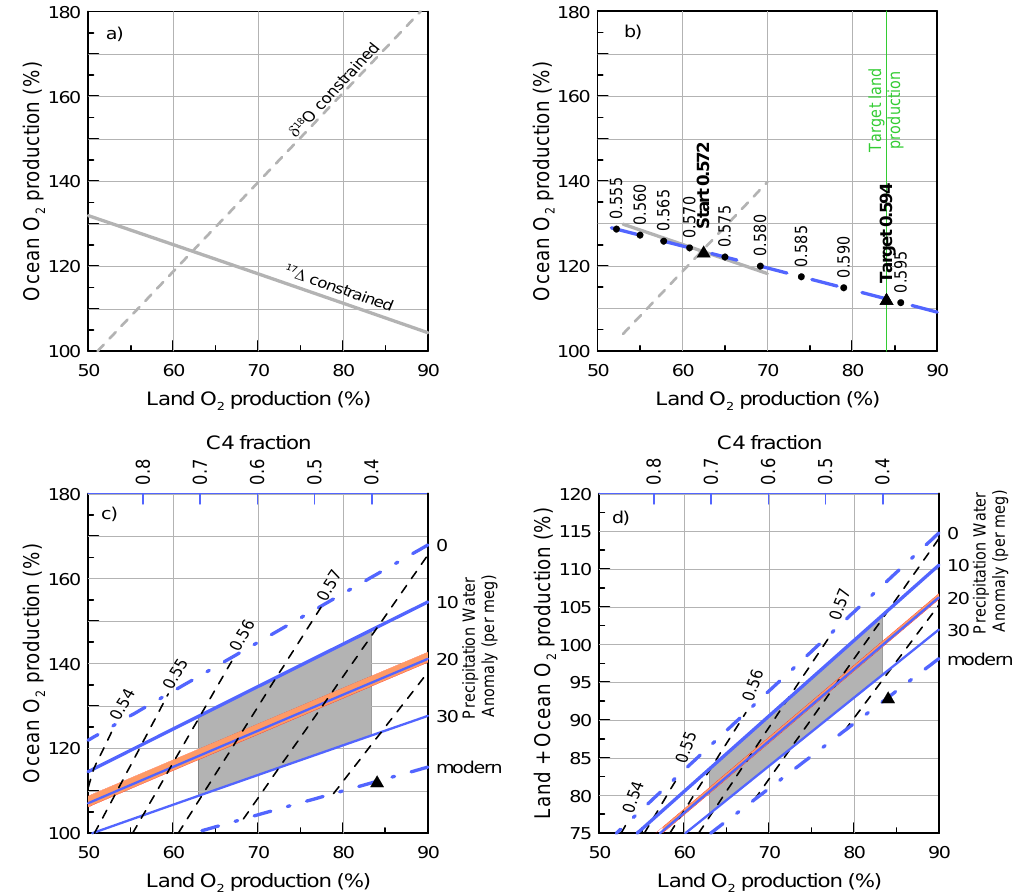
Fig. 3. Plots of ocean O 2 production vs. land O 2 production (a–c) and total O 2 production vs. land O 2 production (d) for the Last Glacial Maximum default scenario (see Table 4). The lines and areas indicate allowable values as constrained by the δ 18 O and 17 1 of paleoatmo- spheric O 2 relative to the modern (100%) production. (a) Gray dashed and solid line: solutions that satisfy δ 18 O atm and 17 1 , respectively, assuming modern humidity and a hydrological anomaly similar to modern. (b) Solutions of (a) in gray. Increasing the relative humidity (black dots and associated labels) drives the intercept of 17 1 and δ 18 O towards the target value for land productivity (see text for details). (c) and (d) The value for land carbon productivity is locked. Therefore, the land O 2 production is inversely proportional to the C4 contribution (top axis). We show solutions for precipitation anomalies from 0 to 40 per meg and soil temperature 5 ◦ C lower than modern. The area in red represents solutions with soil temperatures 4–7 ◦ C lower than modern and a precipitation 17 1 anomaly of 20 per meg lower than modern. Black dashed lines show isolines of global GPP-weighted humidity. The gray area represents solutions we favor. Black triangles show the target value of